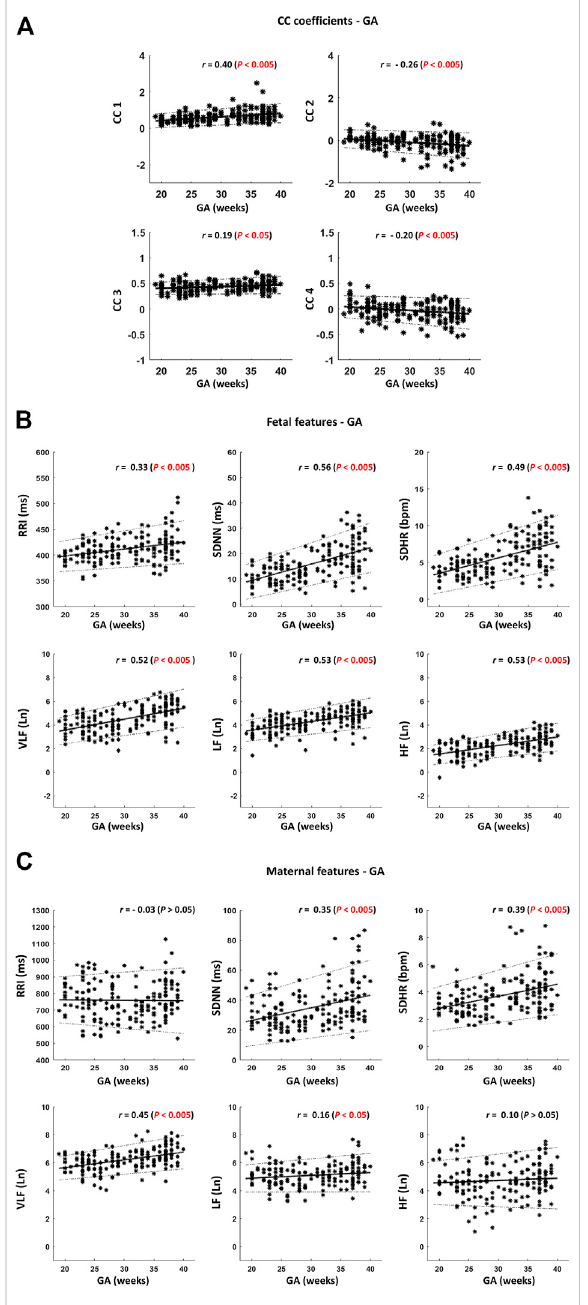
FIGURE 4 Scatter plots for visualizing the correlations described in Table 1. (A) Cross-correlation (CC) coef fi cients – gestational age (GA). (B) Fetal features — GA. (C) Maternal features – GA. Thick blacklinesindicatethebest- fi ttingline.Thedottedblacklines indicate the 95% con fi dence interval (CI). The sample size is 172. r indicates Spearman correlation coef fi